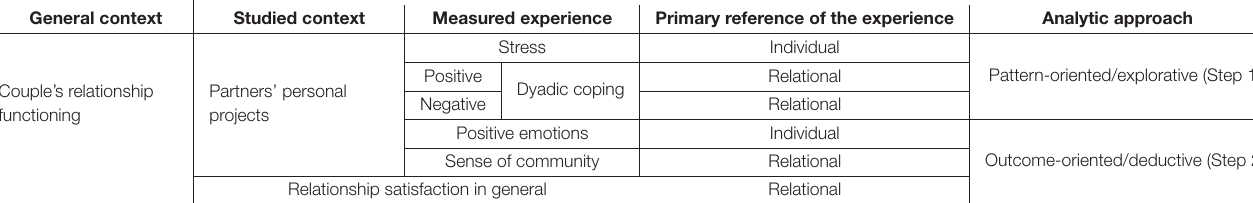
TABLE 1 | Conceptual and methodological network of the